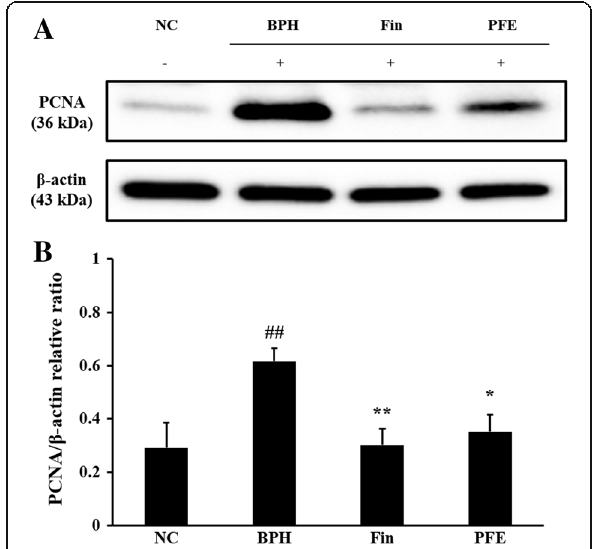
Fig. 7 Effect of PFE on the expression of PCNA in prostatic tissue. Prostatic tissues were homogenized and PCNA/ β -actin protein expression was determined using western blotting: ( a ) expressions of PCNA and β -actin, and ( b ) relative ratio, relative levels of PCNA. The β -actin protein was used as a loading control for quantitative analysis. The relative ratios of protein expression were normalized to β -actin and are represented in quantitative graphs. NC (normal control group), corn oil injection (s.c.) + PBS administration (p.o.); BPH (control group), TP (3 mg/kg)/corn oil injection (s.c.) + PBS administration (p.o.); Fin (positive control group), TP (3 mg/kg)/corn oil injection (s.c.) + finasteride administration (10 mg/kg, p.o.); PFE (PFE-treated group), TP (3 mg/kg)/corn oil injection (s.c.) + PFE administration (200 mg/kg, p.o.). Data are presented as mean ± S.E.M. ( n = 6). Significant differences at ## P < 0.01 compared with the NC group. Significant differences at * P < 0.05 and ** P < 0.01 compared with the BPH group. BPH, benign prostatic hyperplasia; Fin, finasteride; PBS, phosphate-buffered saline; PFE, Ponciri fructus extract; p.o., peroral; s.c., subcutaneously; PCNA, proliferating cell nuclear antigen; TP, testosterone propionate